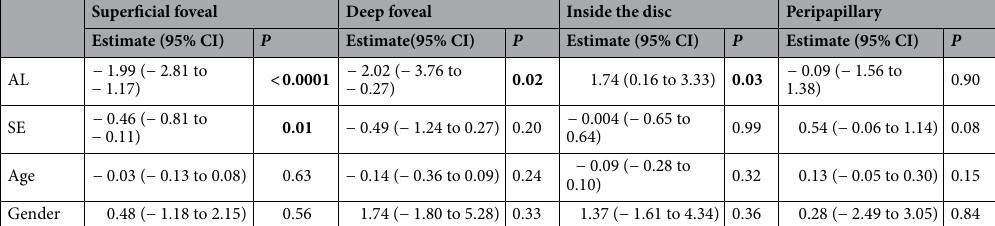
Superficial foveal Deep foveal Inside the disc